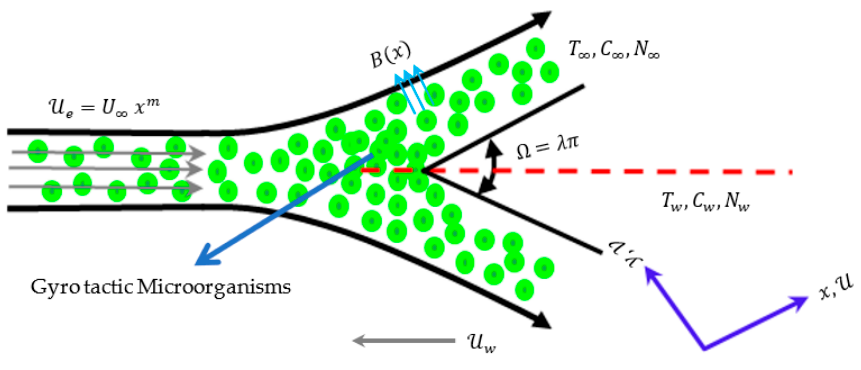
Figure 1. Physical con fi guration of Falkner–Skan fl ow model.